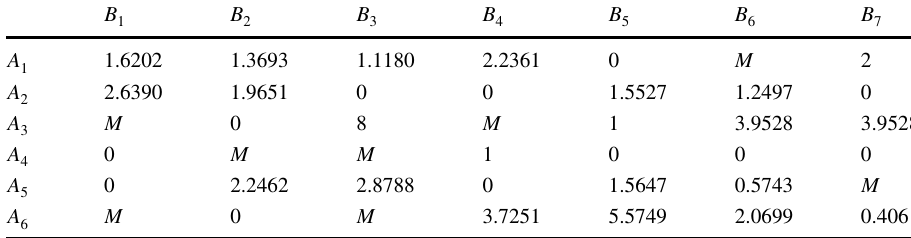
Table 6 Perceived